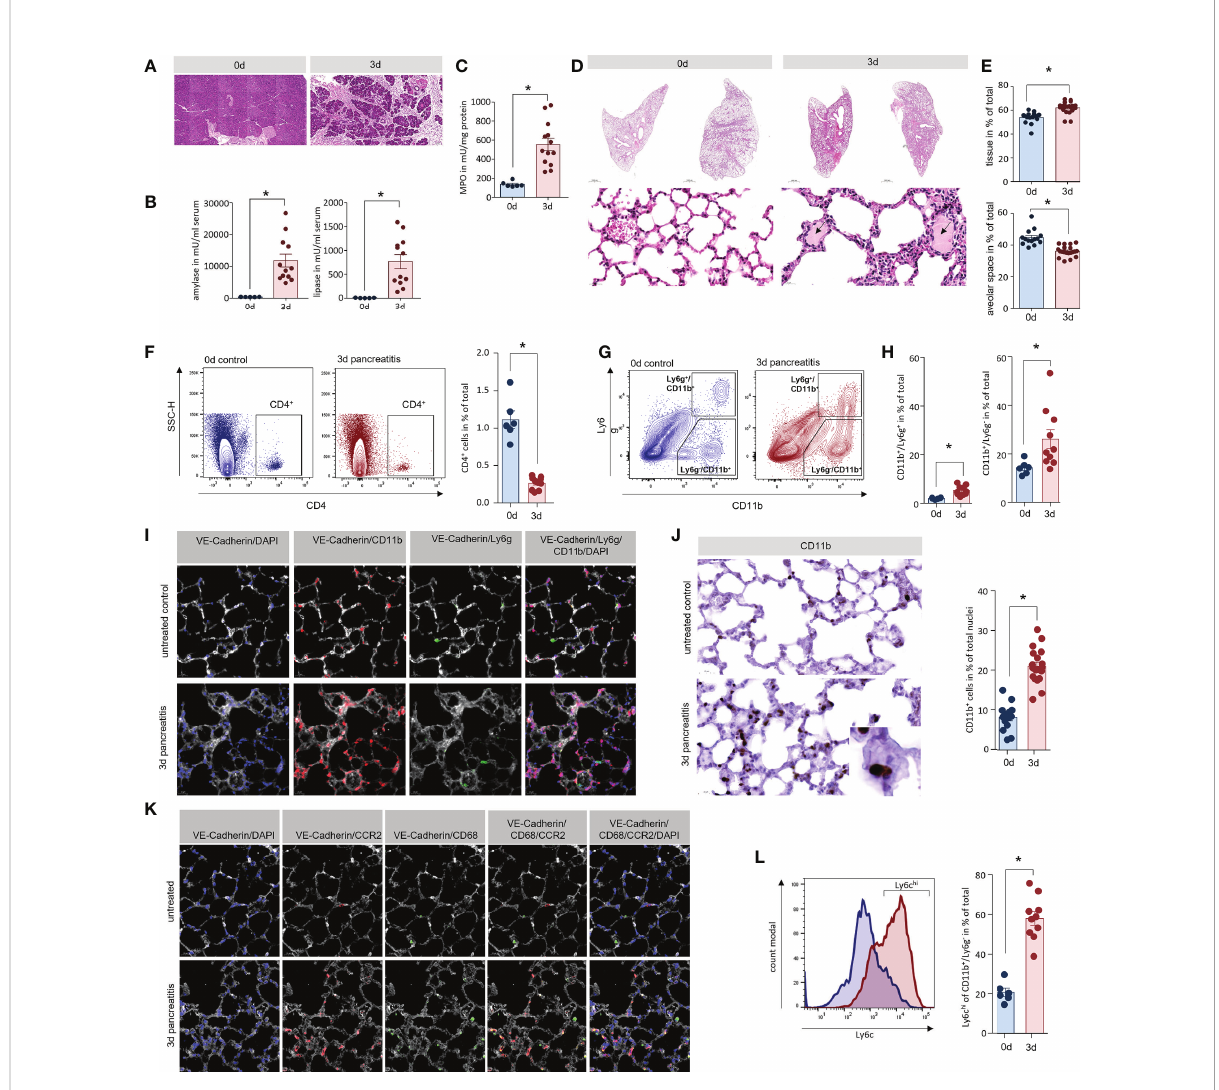
FIGURE 1 Lung damage in a mouse model of severe acute pancreatitis. (A) H&E staining of pancreatic sections illustrate organ damage, in fl ammation and acinar cell necrosis in the pancreas of mice. (B) Activity of amylase and lipase in serum of mice were signi fi cantly increased 3d after onset of disease. (C) Myeloperoxidase (MPO) activity a marker of the presence of in fl ammatory cells was elevated in lung tissue. (D) H&E staining showed a clear increase of wall thickness and oedema within the alveolus (black arrows). (E) An analysis of the alveolar space/tissue volume ratio showed a signi fi cant decrease of the alveolar lung volume. Classi fi cation of leukocytes from lung tissue of mice by fl ow cytometry analysis of surface markers. (F) CD4 + cells represent a minor population of immune cells in lung but show a signi fi cant reduction after onset of AP. (G) Cells of the innate immune system were distinguished by the expression of the cell surface markers Ly6g and CD11b. (H) The number of CD11b + /Ly6g + (neutrophils) as well as CD11b + /Ly6g - cells (monocytes) are signi fi cantly increased. (I) Fluorescent labelling of lung tissue con fi rmed localisation of CD11b + cells in the lung. After the induction of AP CD11b + /Ly6g - monocytes (red) represent the majority of detectable cells in lung tissue, whereas Ly6g + neutrophils (green) were observed in much lower numbers. (J) CD11b labelling showed a clear redistribution of CD11b + cells into the interalveolar septs. Cell counts of CD11b + positive cells in lungs were signi fi cantly increased after the induction of pancreatitis in mice. (K) After induction of AP in mice, CCR2 + monocytes (red) are located within the VE-Cadherin (white) positive areas of lung tissue, whereas tissue resident alveolar macrophages were labelled by CD68 (green) and are located at the border of the alveolar space. (L) Flow cytometry analysis of CD11b + /Ly6g - cells in lung after induction of AP showed an increased expression of the monocyte marker Ly6c on their surface. All graphs represent 6 or more animals per group. Statistically signi fi cant differences were, tested by unpaired student`s t-test for independent samples and signi fi cance levels of p<0.05 are marked by an